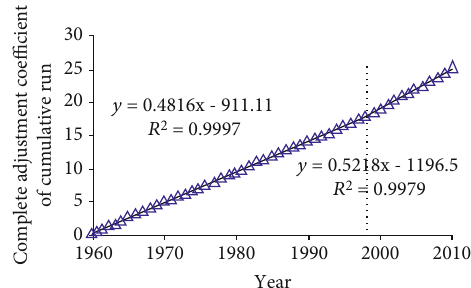
Figure 6: Complete adjustment coe ffi cient of cumulative runo ff